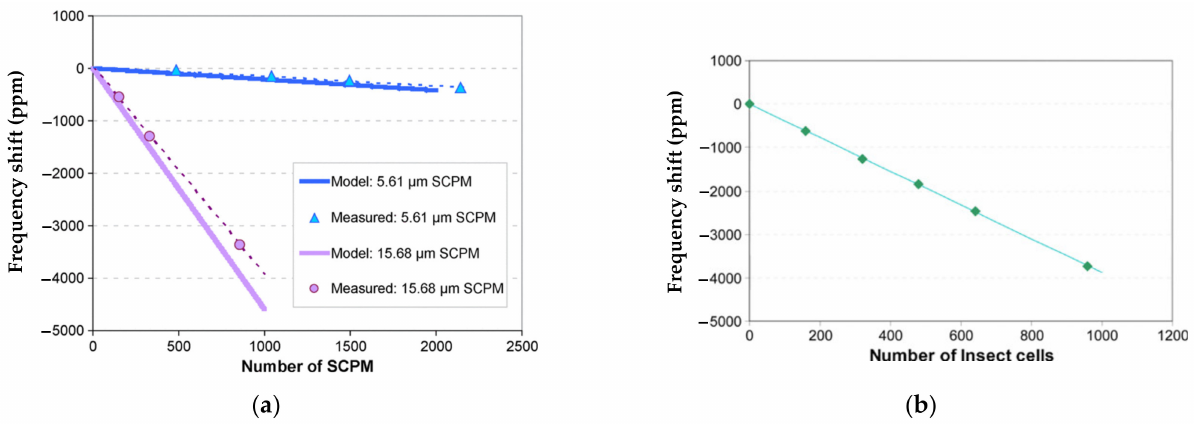
Figure 27. Relationship between the frequency shift and the number of analytes attached to the resonator from. ( a ) SCPMs; ( b ) High Five insect cells. Reprinted with permission from Ref.